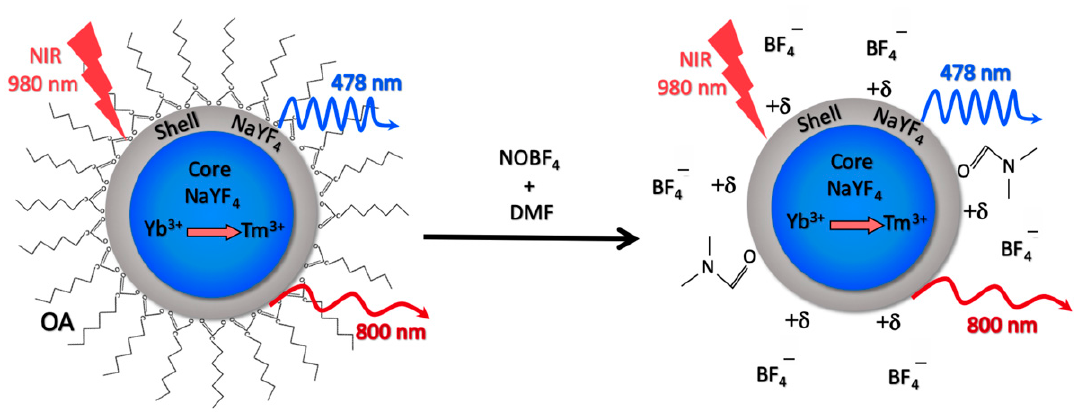
Figure 1. A schematic illustration of upconversion nanoparticles oleic acid (UCNP-OA) core/shell structure and the ligand exchange method converting UCNP-OA into UCNP-NOBF 4 . DMF—dimethylformamide.